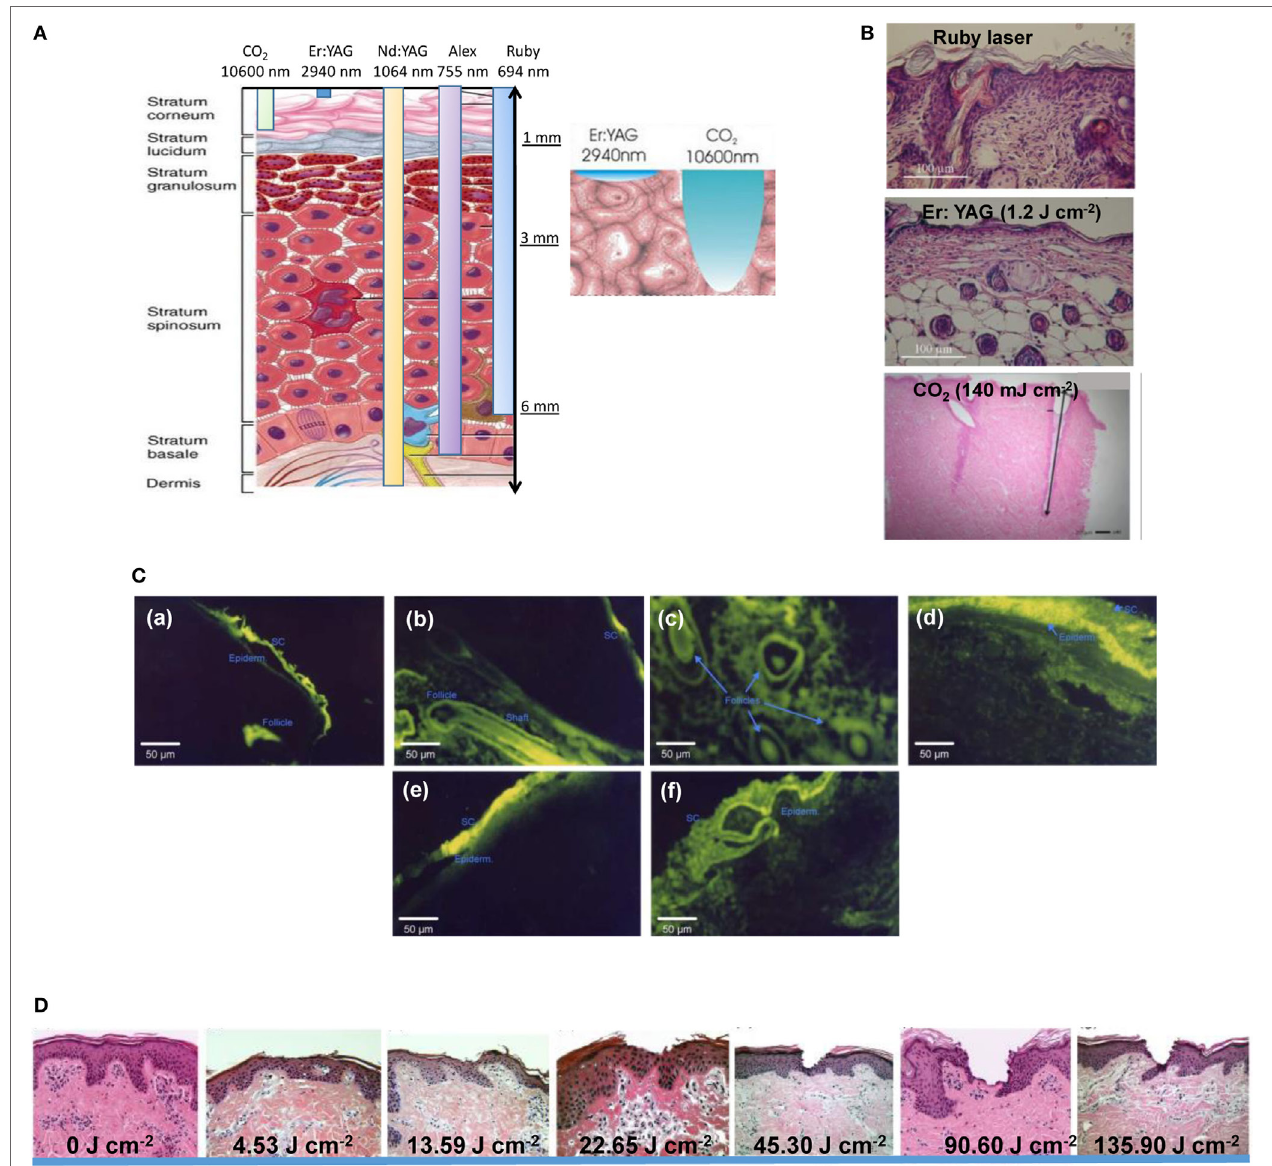
FigURe 3 | (A) Penetration depth through the skin tissue of different lasers [accessed at http://www.dekalaser.com/img/ENGskinsurgery_02.jpg (15 December 2017)]. (b) Histological examination of nude mouse back skin treated with ruby laser, erbium–yttrium–aluminum–garnet (Er:YAG) (1.2 J cm − 2 ) and CO 2 (140 mJ cm − 2 ) lasers. (C) Fluorescence microscopy examination after topical administration of FITC and FITC-labeled dextrans via pig skin for 30 min: (a) topical FITC delivery into the skin treated by Er:YAG laser at 1.7 J cm − 2 in the longitudinal section, (b) FITC delivery into the skin treated by Er:YAG laser at 1.7 J cm − 2 in the